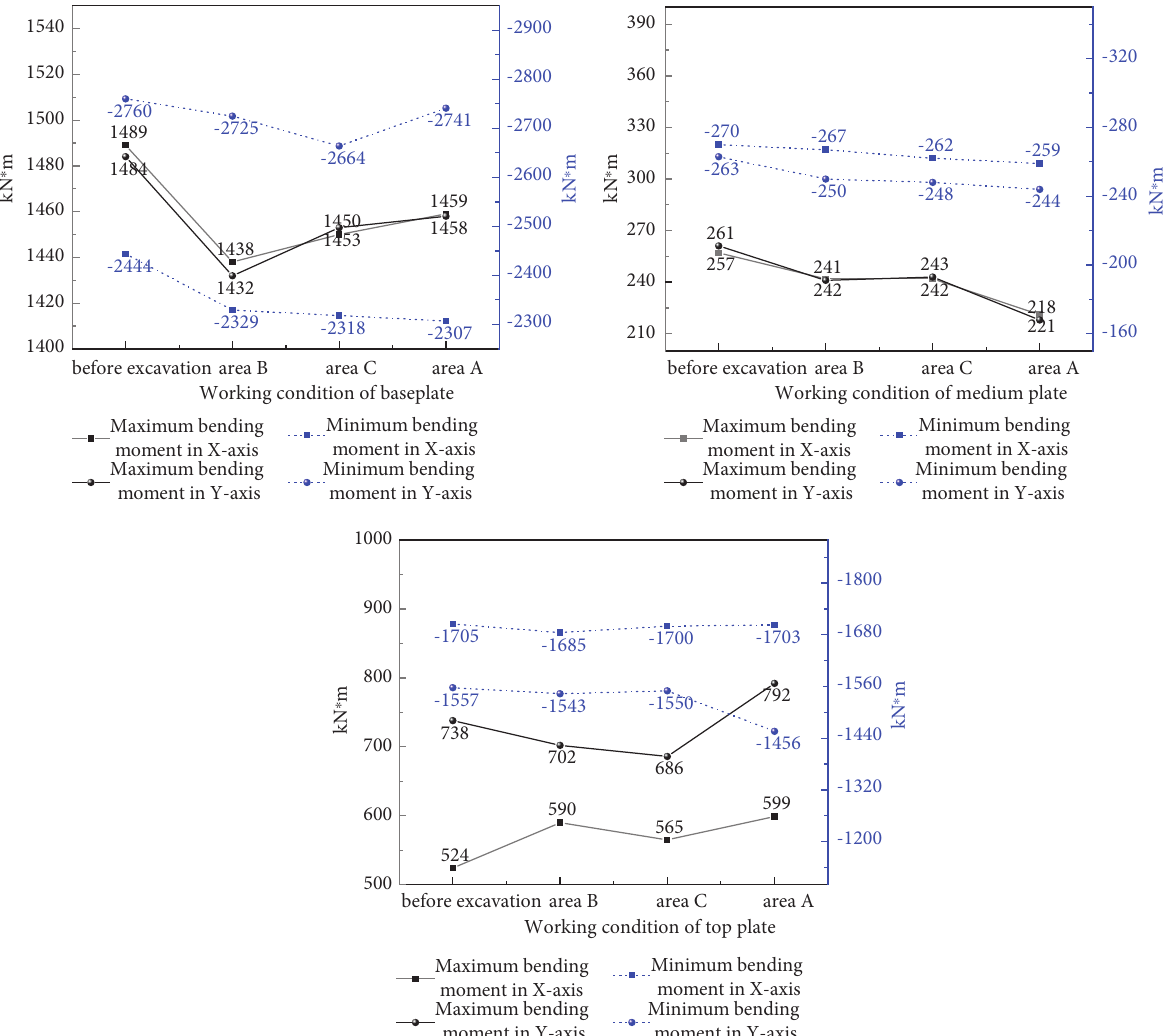
Figure 6: Maximum bending moment of the station slab from the foundation pit excavation to the pit